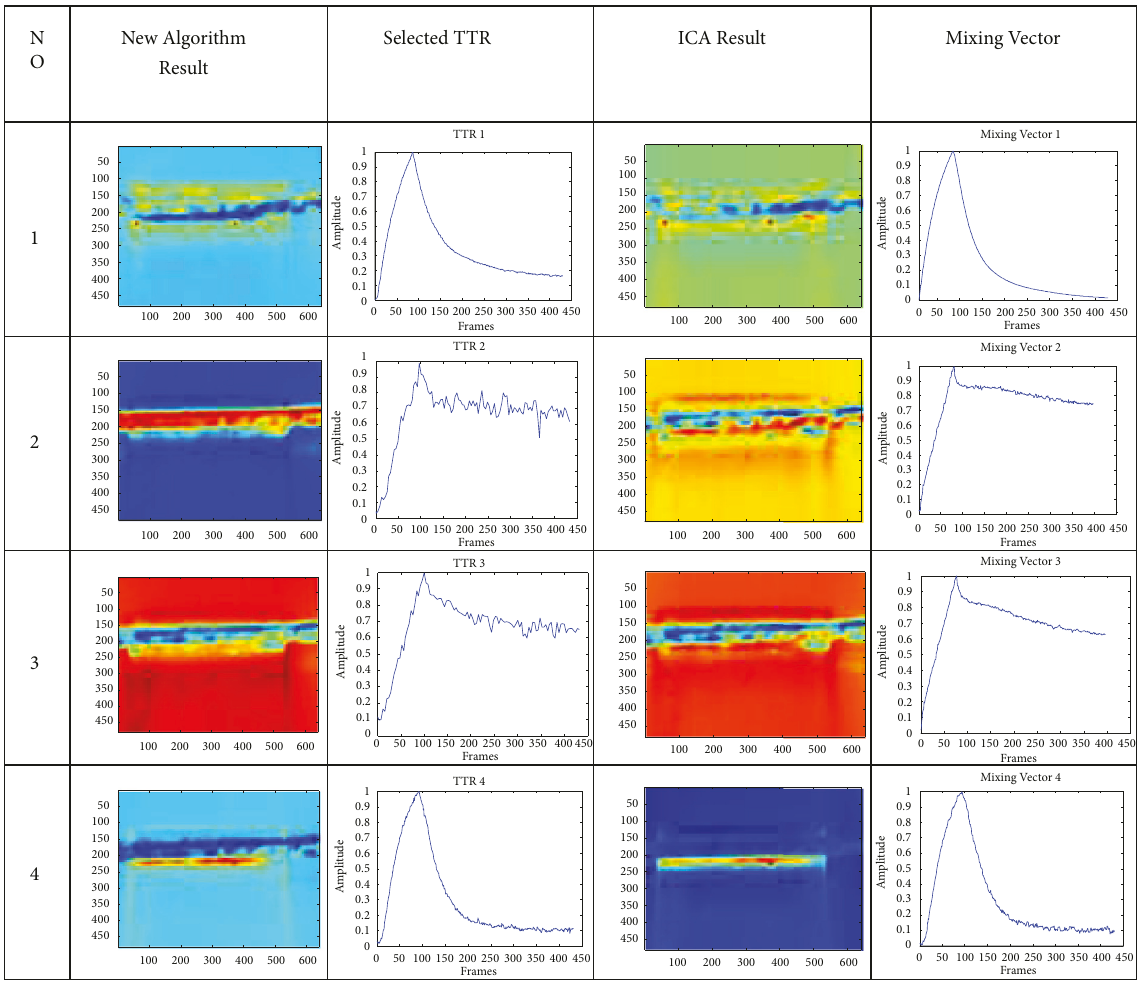
Figure 18: The proposed algorithm and ICA result of sample 2.